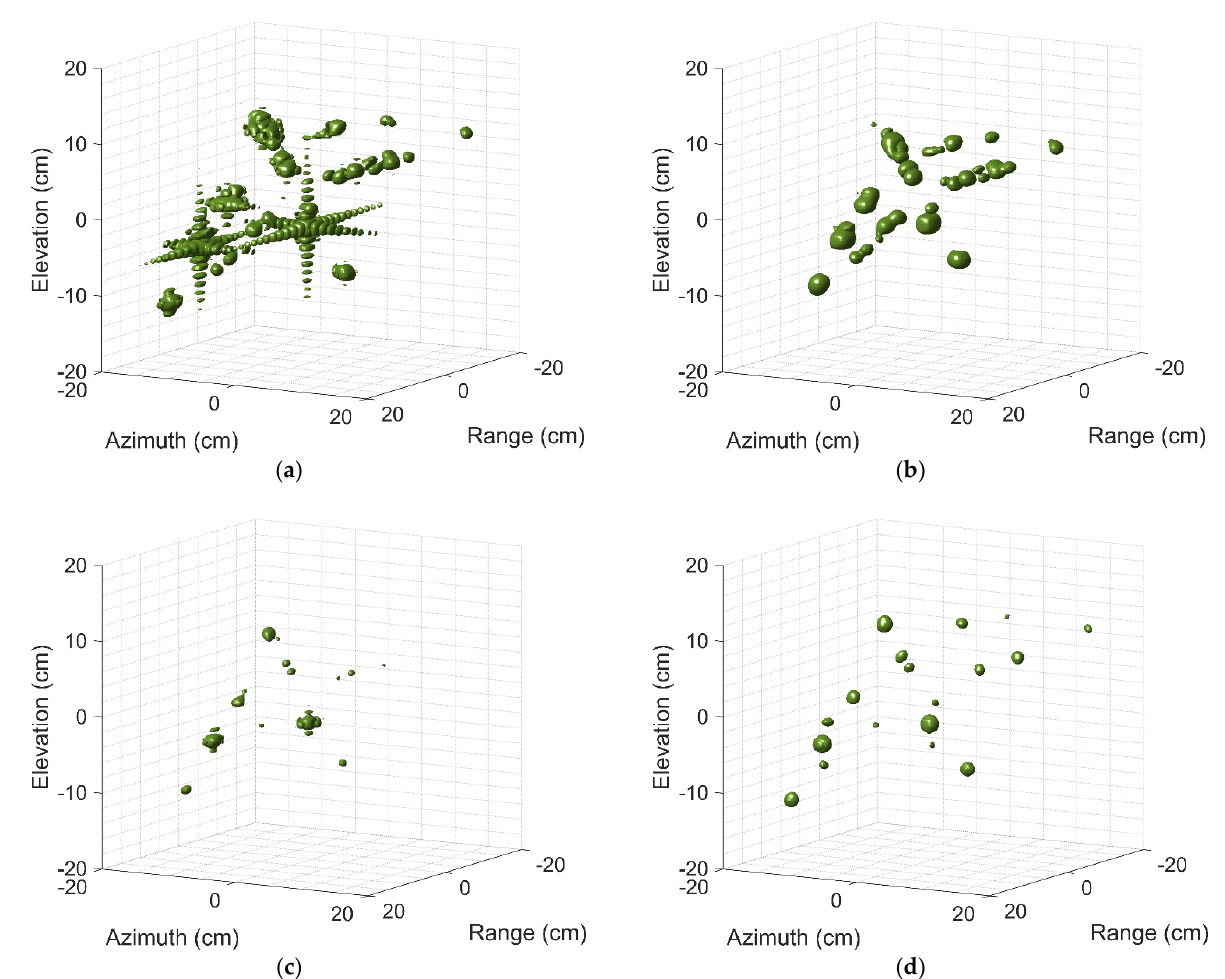
Figure 9. Three − dimensional images of aircraft A380 by ( a ) 3D IFFT without windowing, ( b ) 3D IFFT with windowing, ( c ) BPDN, ( d ) SR − CNN. ( c ) BPDN, ( d )